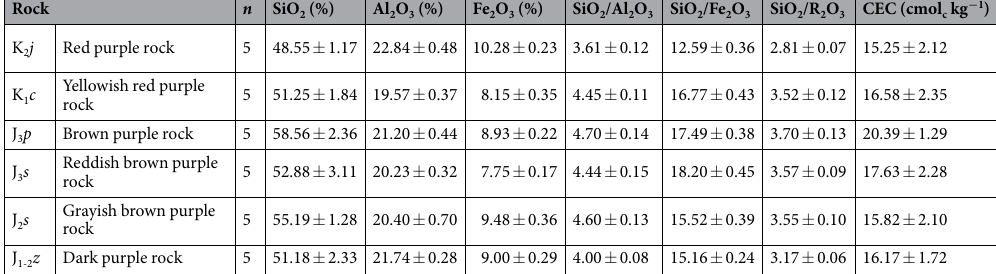
Table 2. SiO 2 /Al 2 O 3 , SiO 2 /Fe 2 O 3 and SiO 2 /R 2 O 3 ratios of the clay fraction in the purple rocks.